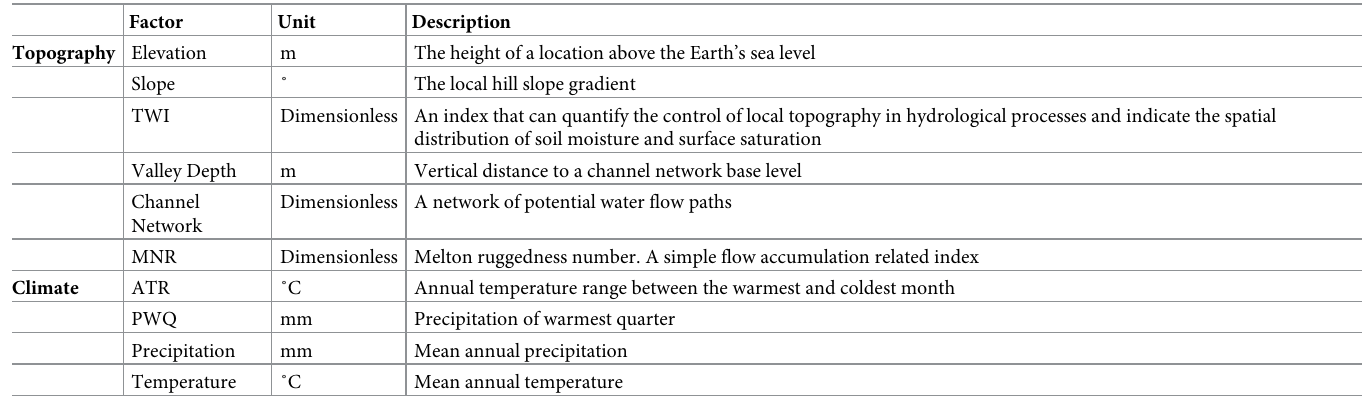
Table 1. Description of the used topographic indicators and climate